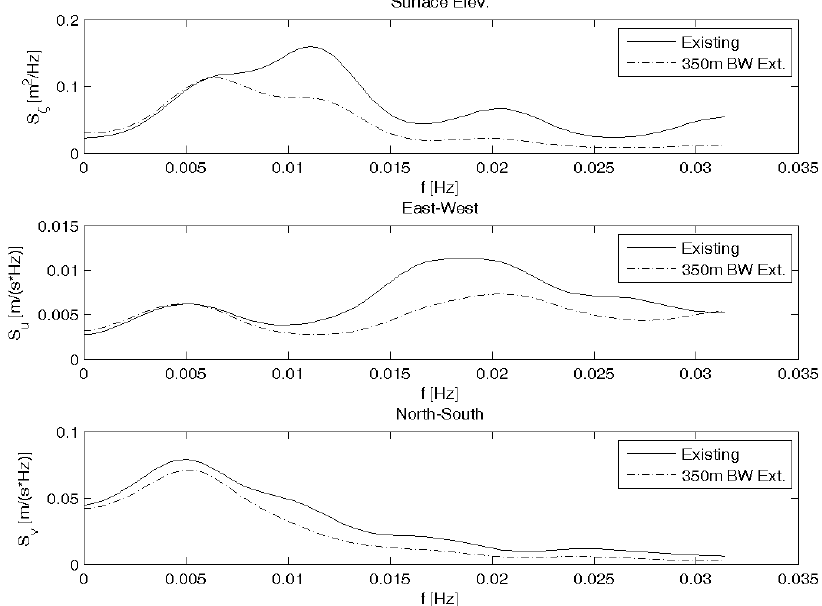
Figure 9. Surface elevation ( top ), East-West current ( middle ) and North-South current frequency spectra for existing and 350 m breakwater cases at the port entrance — Event 1.